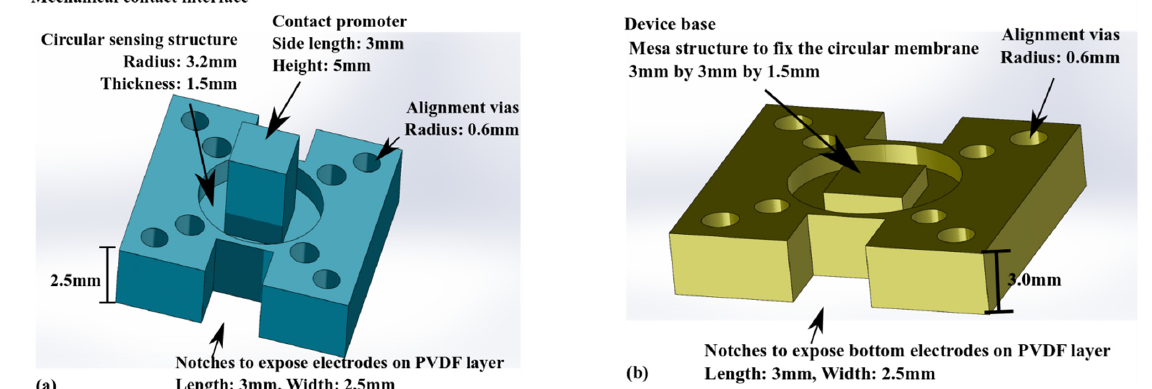
Figure 2. Detailed designs of structures to be 3D printed. ( a ) The elastic contact interface, ( b ) The device base.